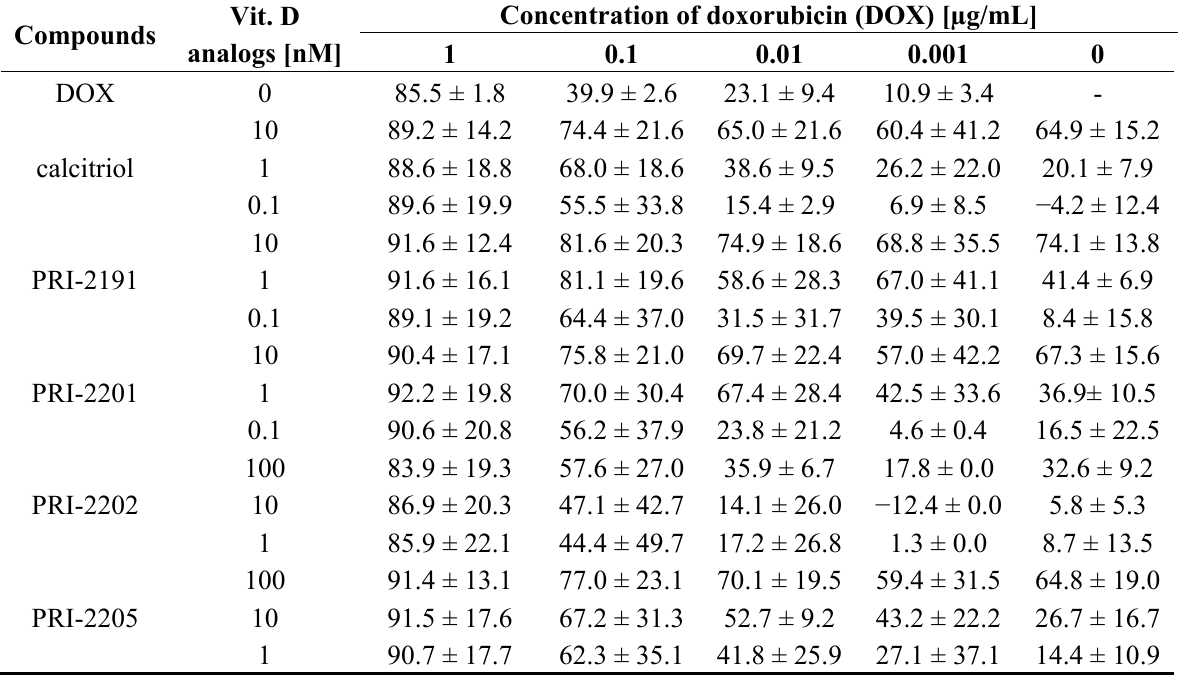
Table 3. The proliferation inhibition of HL-60 cells exposed to calcitriol or its analogs and